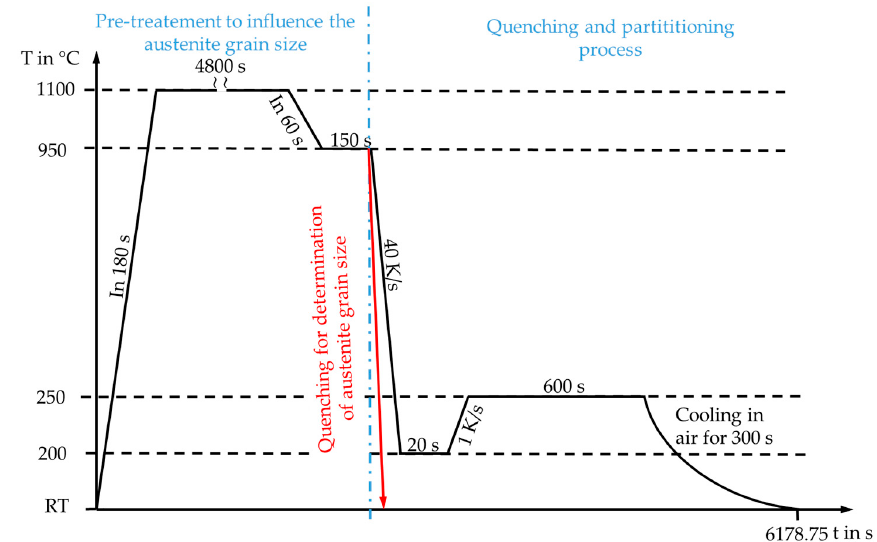
Figure 6. Heat treatment route 2. Grain growth 1.